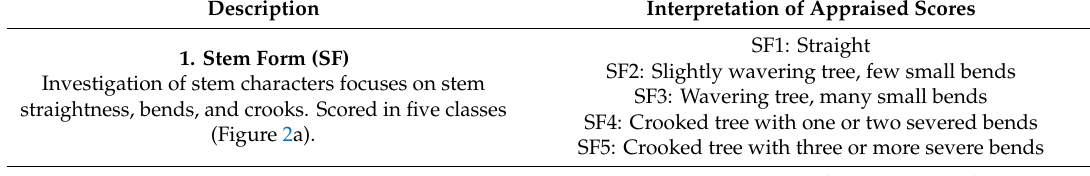
Table 2. Description of the appraised scores for tree